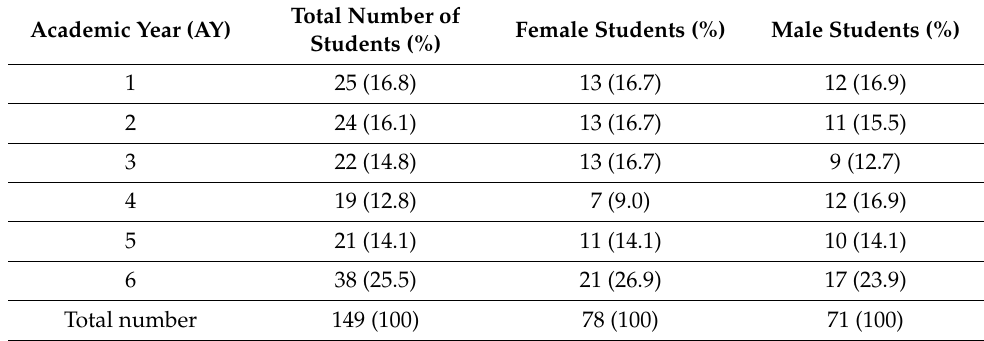
Table 2. Distribution of participating students by academic year and gender.